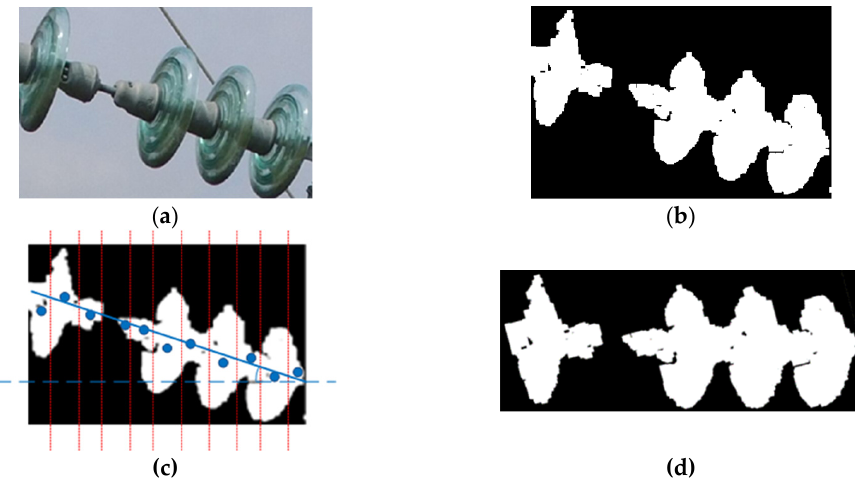
Figure 7. The process of the insulator image rotation algorithm: ( a ) target image; ( b ) binary image; ( c ) obtain the rotation angle; ( d ) rotated image.